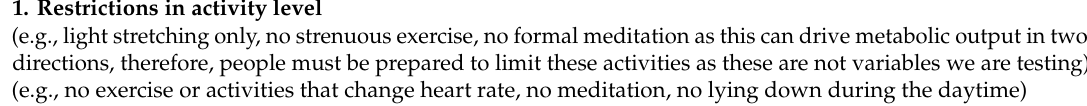
Table 1. Brigham and Women’s Hospital Division of Sleep and Circadian Disorders Intensive Physiological Monitoring unit studies: psychologically relevant concerns.